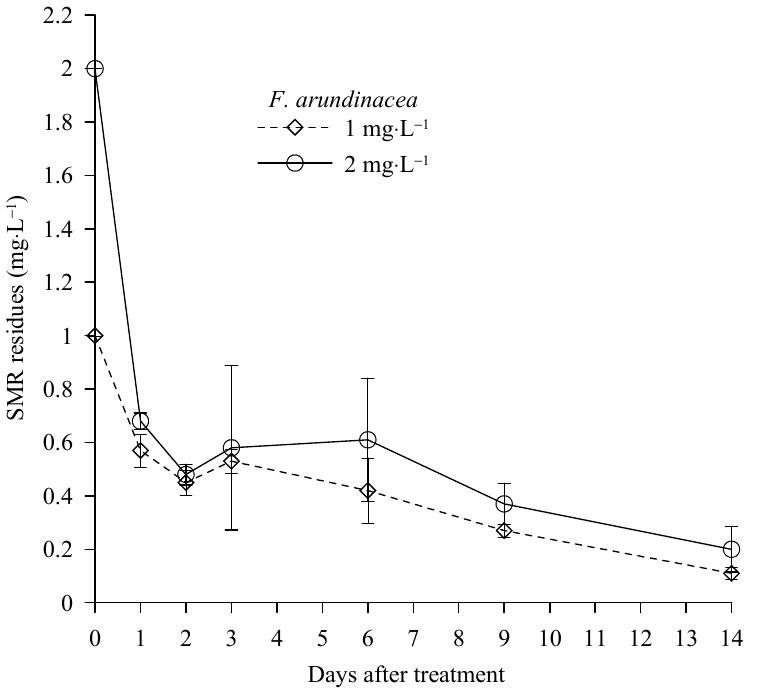
Figure 4. S-metolachlor (SMR) residues (mg L − 1 ) determined in the growth media of F. arundinacea (tall fescue) at 1, 2, 3, 6, 9, 14 days after treatments (DAT) with 1 and 2 mg L − 1 SMR concentrations. Vertical bars represent ± confidence intervals ( p = 0.05, n = 9).